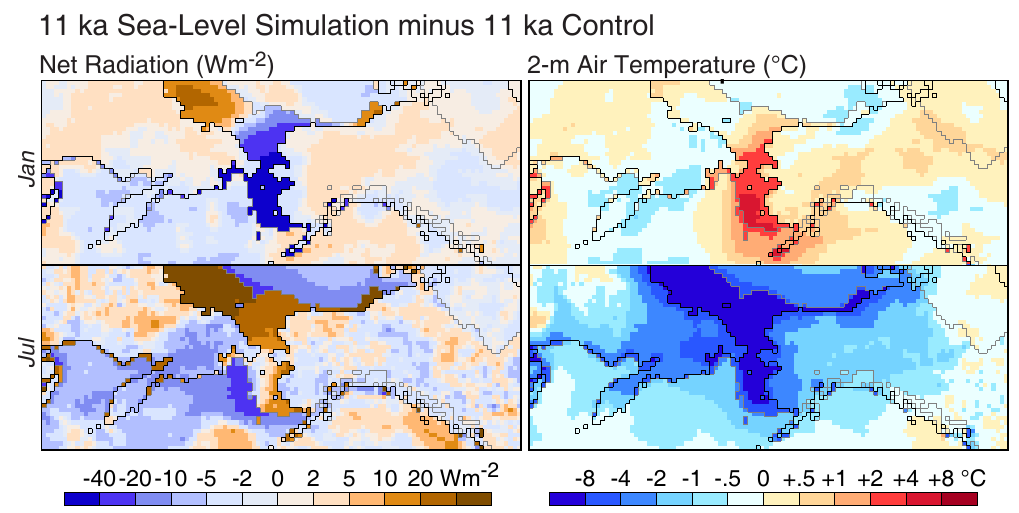
Figure 6. Results of 11ka Sea Level experiment. Panels show the effect of flooding the land bridge at 11ka ( 11ka Sea Level minus 11ka Control ). Net radiation (left) and 2m air temperature (right) for January (upper) and July (lower). Strong winter warming and summer cooling is seen over areas of flooded ocean shelf and adjacent land areas. Ice-sheet and coastal outlines as in Fig.